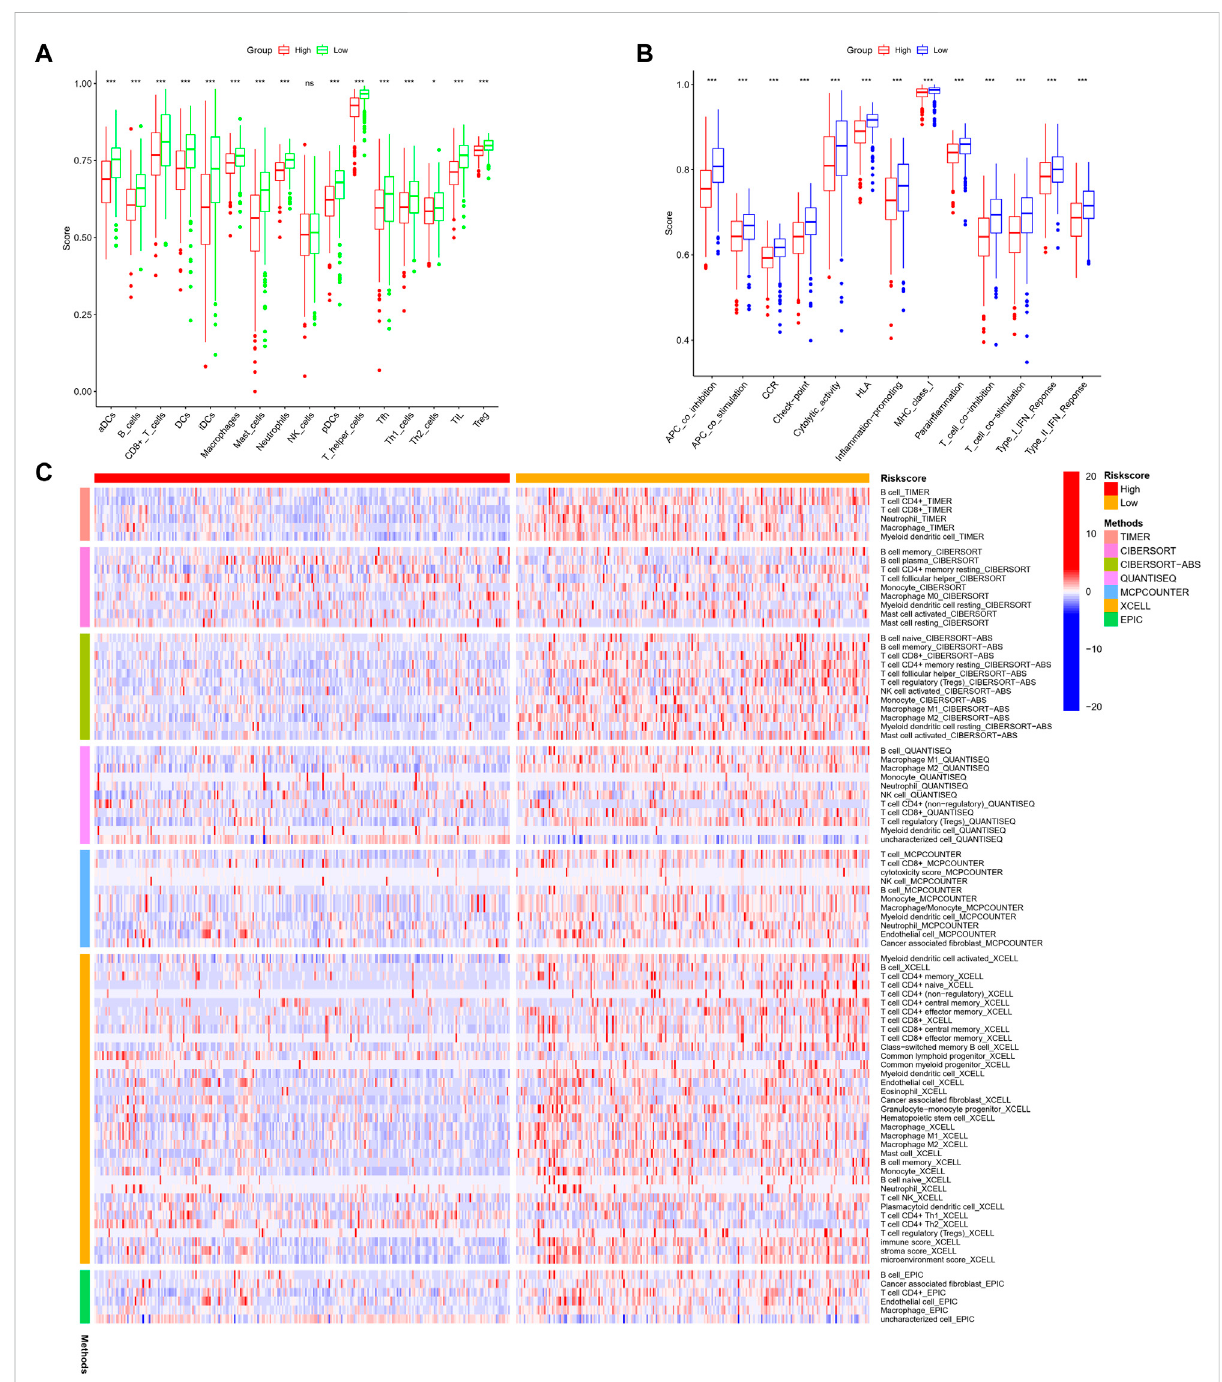
FIGURE 6 (A,B) Comparisonoftheenrichmentscoresof16typesofimmunecellsand13immune-relatedpathwaysbasedonthessGSEAscoresbetween low- (green box) and high-risk (red box) groups in the TCGA cohort. (C) Comparison of the high- and low-risk groups using different methods. (wilcox.test, p values were as follows: * p < 0.05; ** p < 0.01; *** p <